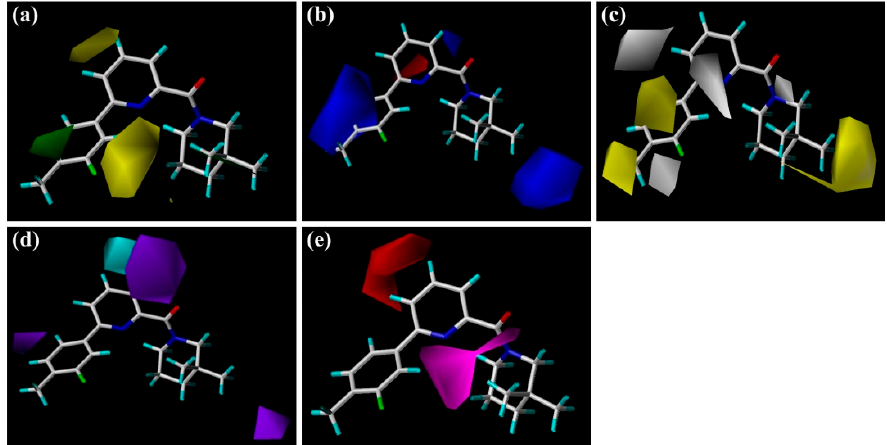
Figure 3. The contour maps of CoMSIA model based on compound 1 . ( a ) Steric field: green and yellow contours indicate regions where bulky groups increase and decrease activity. ( b ) Electrostatic field: red and blue contours indicate regions where negative charge increase and decrease activity. ( c ) Hydrophobic field: yellow and gray contours indicate favorable and unfavorable hydrophobic groups. ( d ) H-bond donor field: cyan and purple contours indicate favorable and unfavorable H-bond donor groups. ( e ) H-bond acceptor field: magenta and red contours indicate favorable and unfavorable H- bond acceptor groups.